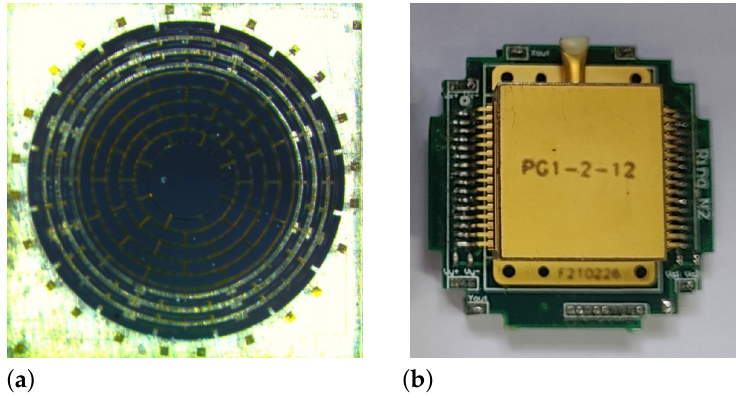
Figure 14. The photos of the resonator ( a ) and the vacuum package ( b